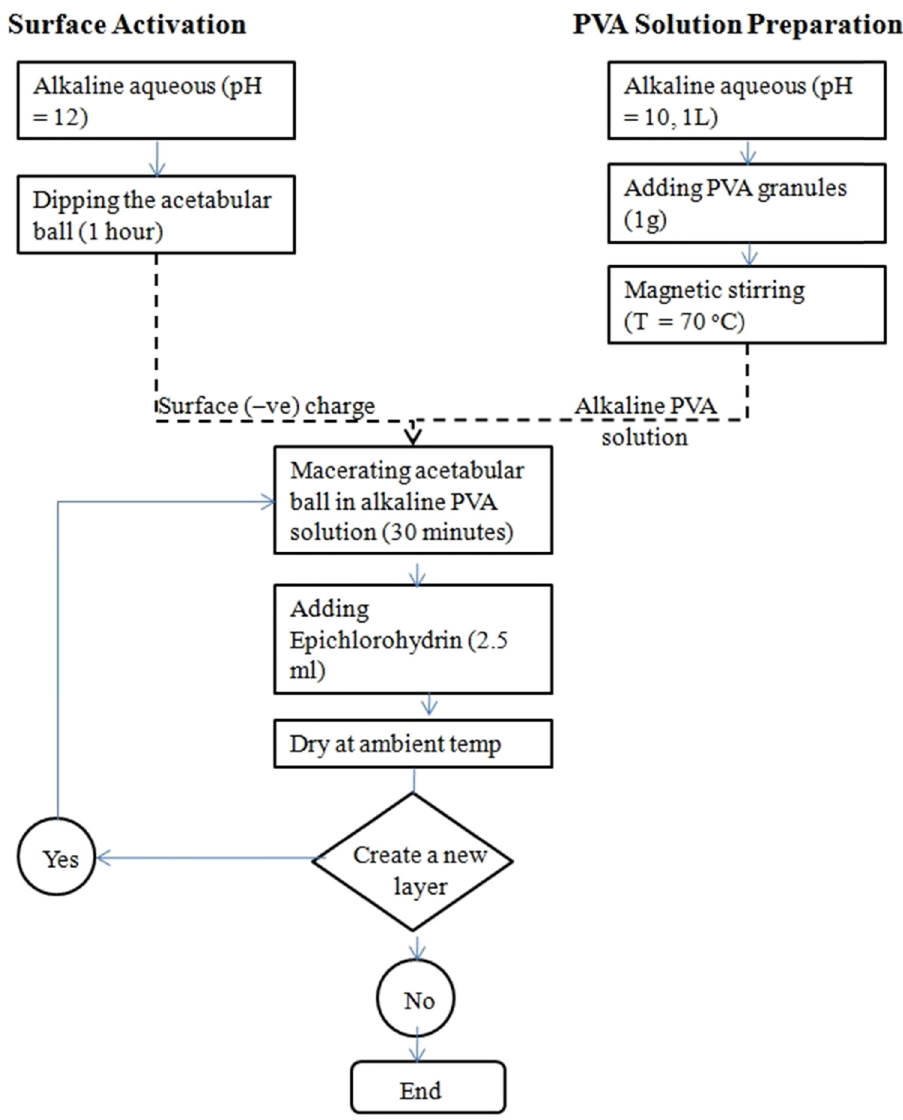
Figure 4: Flow chart shows the steps used to coat the acetabular head with a layer - by - layer of